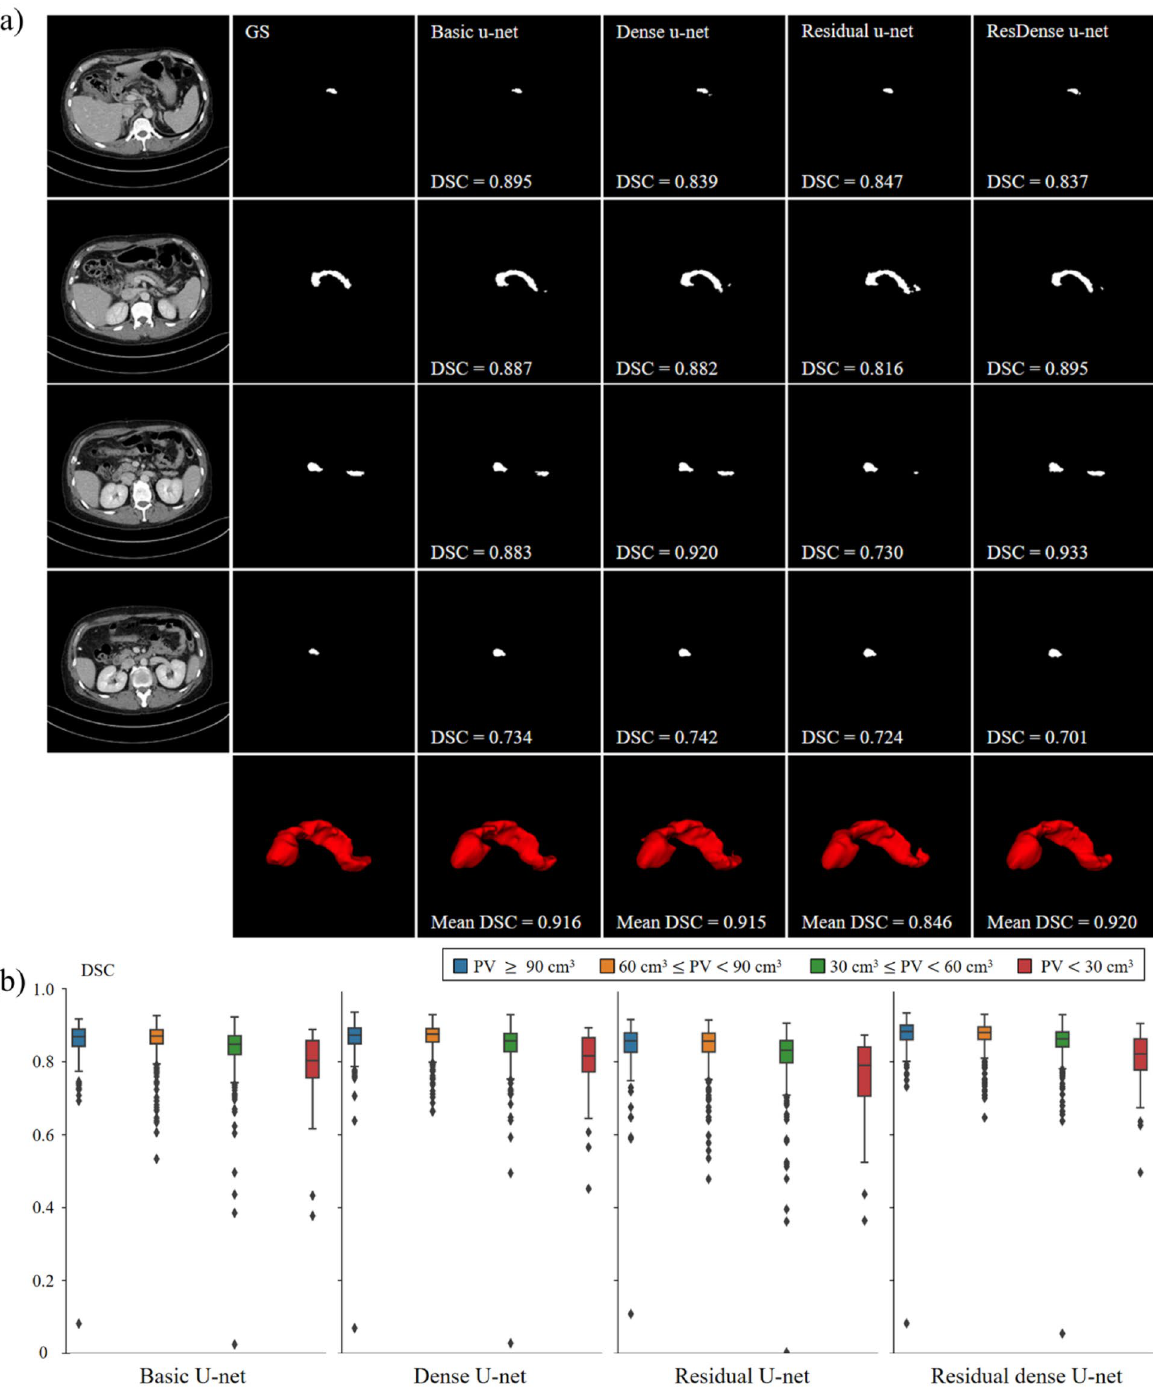
Figure 3. ( a ) Representative examples of pancreas segmentation in the 2D axial plane and 3D volume of one patient. ( b ) DSC metric in each deep learning model according to the volume of the pancreas. GS, gold standard; DSC, dice similarity coefficient; ResDense, residual dense; PV, pancreatic